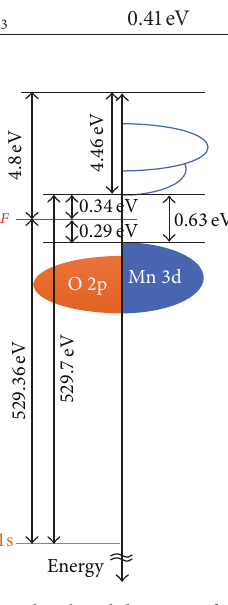
Figure 7: Complete band diagram of LSMO